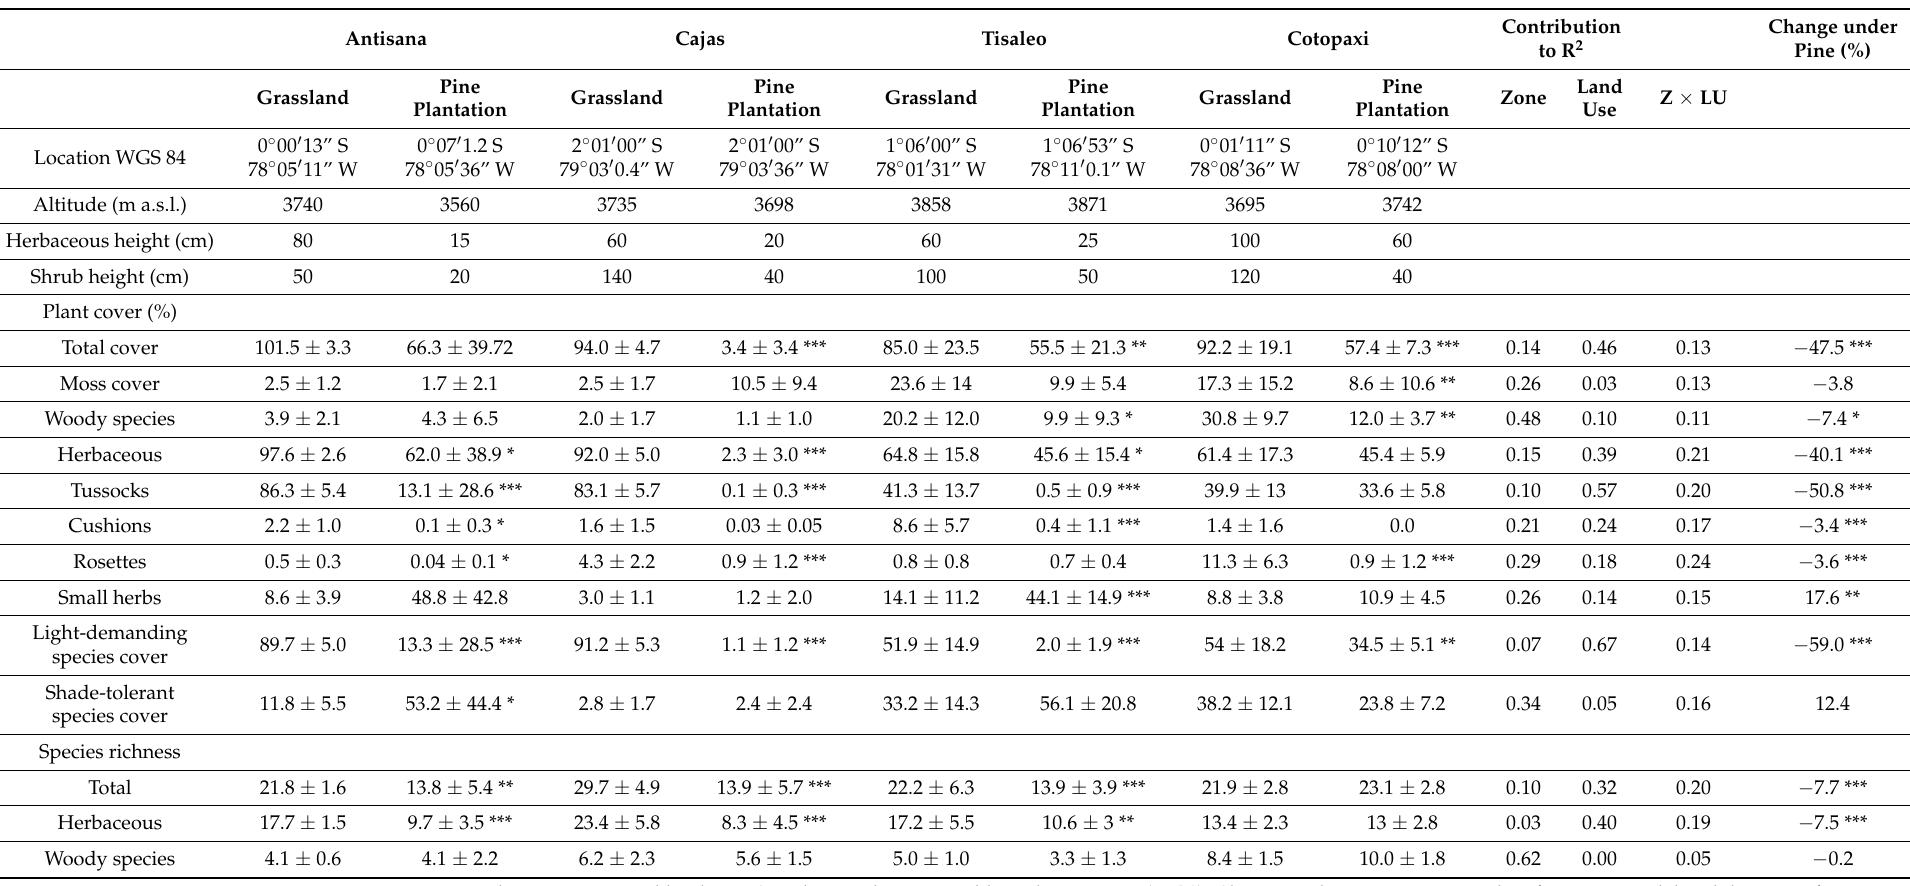
Table 2. Comparison of the plant composition and diversity among the four study zones (Antisana, Cajas, Tisaleo and Cotopaxi) and the land-use types (grasslands vs. pine plantations). Contribution Change under Antisana Cajas Tisaleo Cotopaxi to R 2 Pine (%) Land Pine Pine Pine Pine Z × Zone Grassland Grassland Grassland Grassland Use Plantation Plantation Plantation Plantation